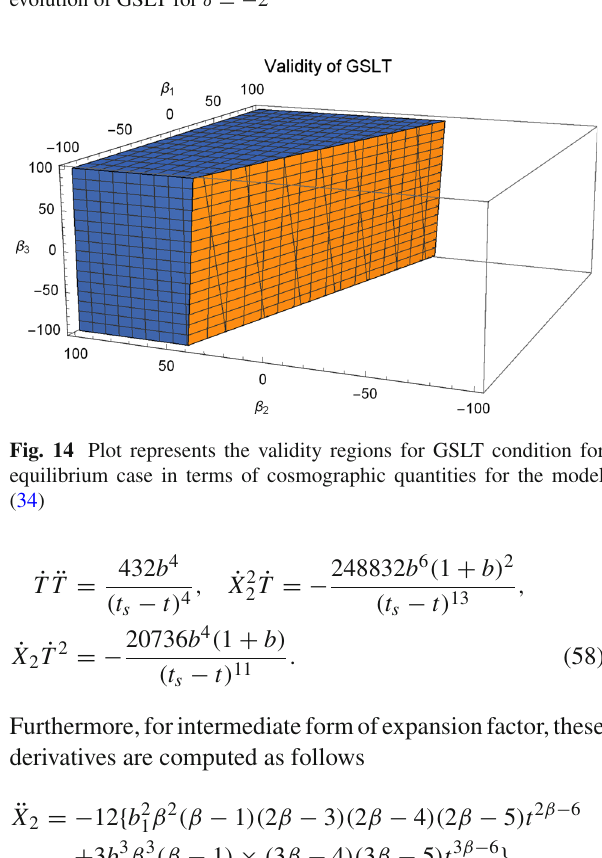
Fig. 13 Left plot represents the validity regions for logarithmic corrected entropy in intermediate case with δ = 2, right graph corresponds to evolution of GSLT for δ = − 2